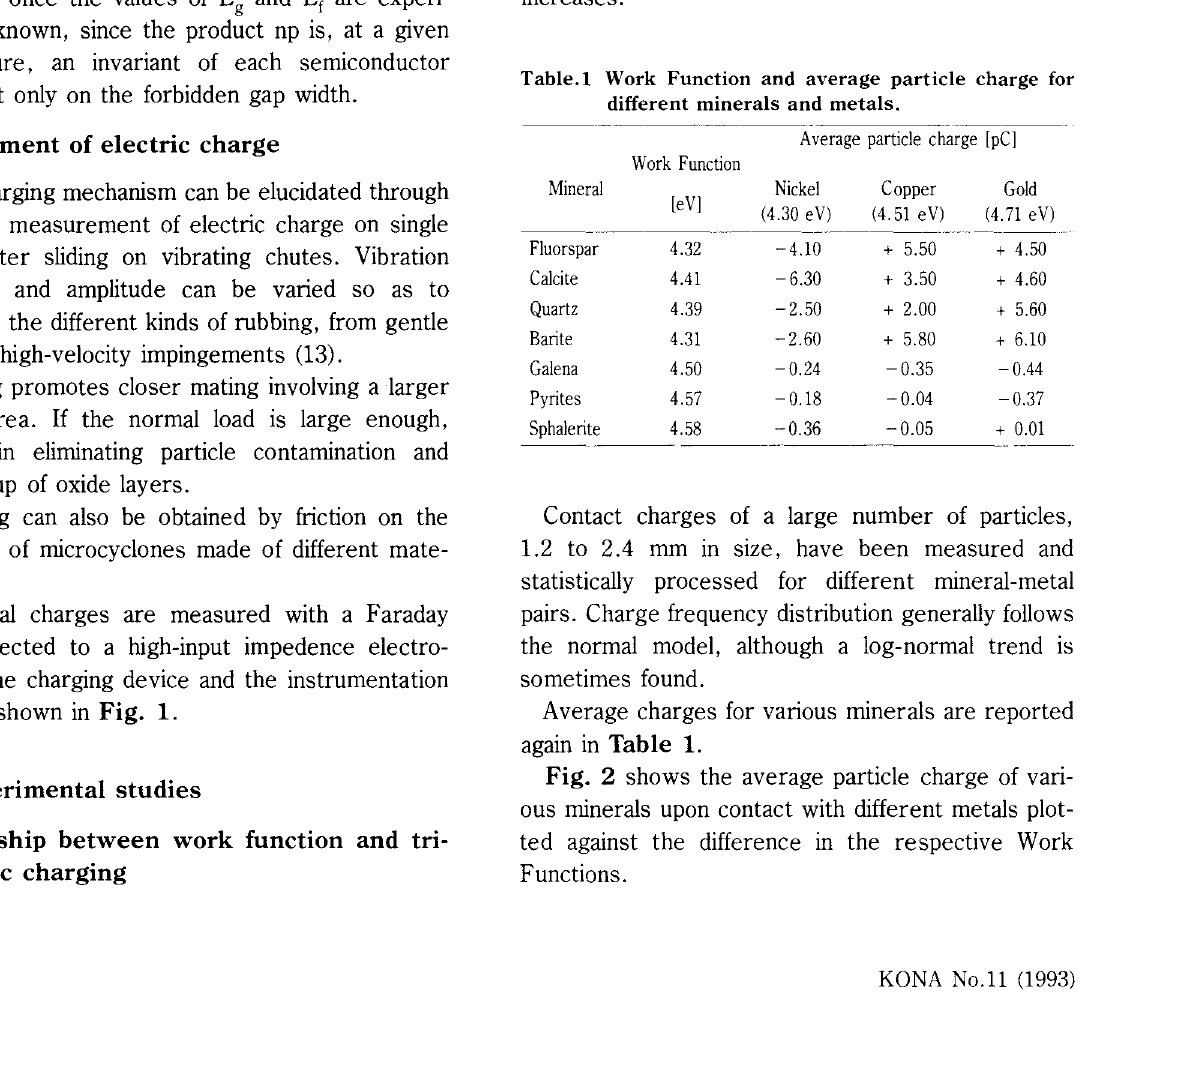
Table.l Work Function and average particle charge for different minerals and